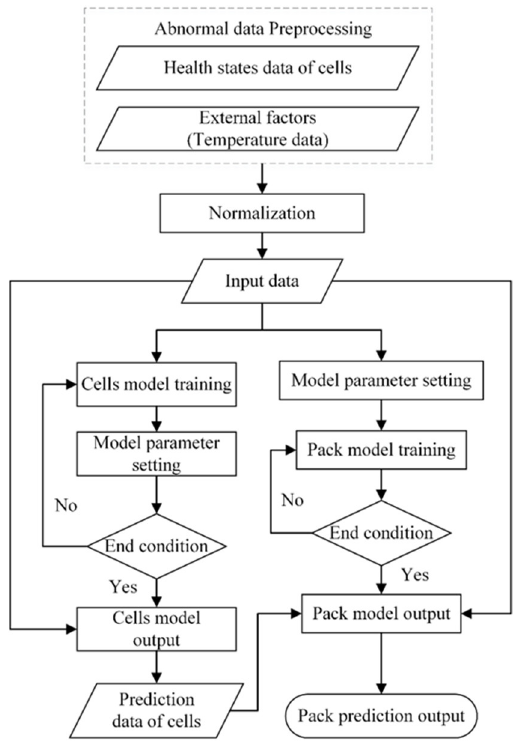
Figure 5. Flow chart of the proposed method.